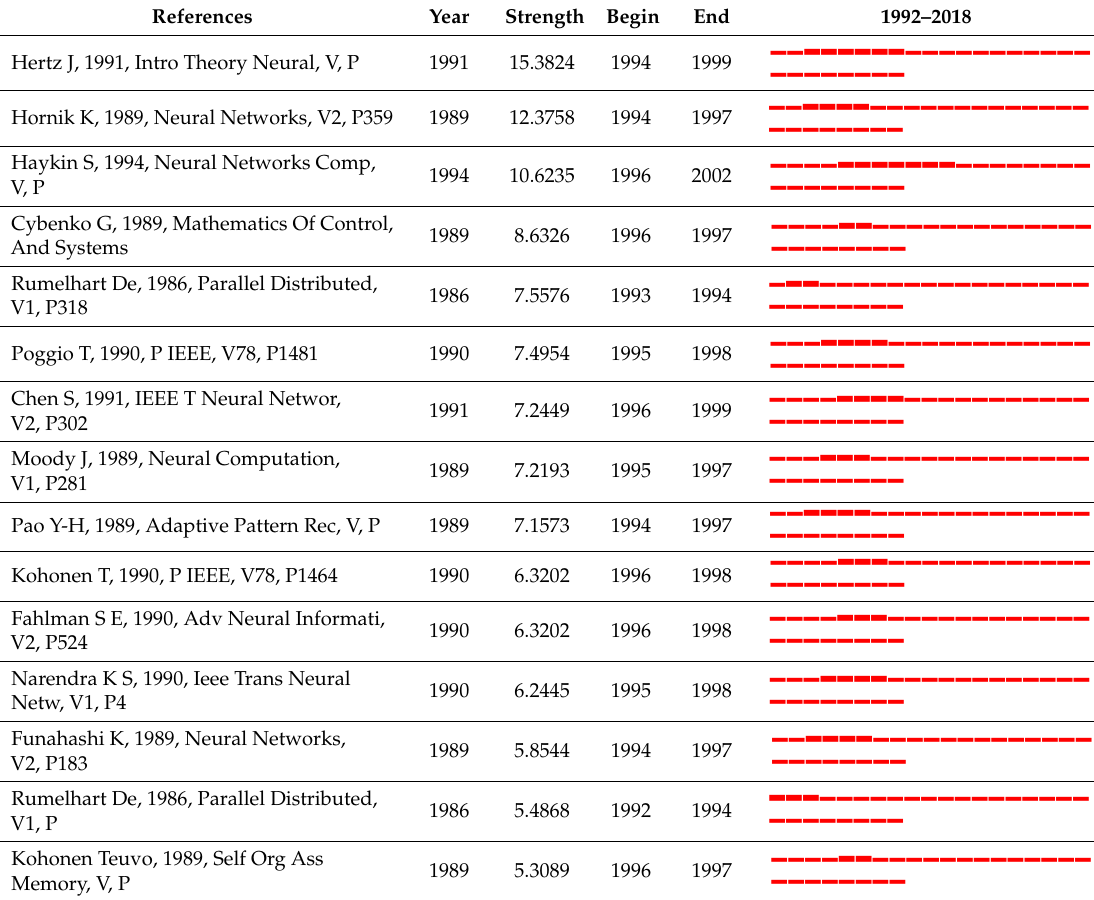
Table 8. Top 30 References with the Strongest Citation Bursts.